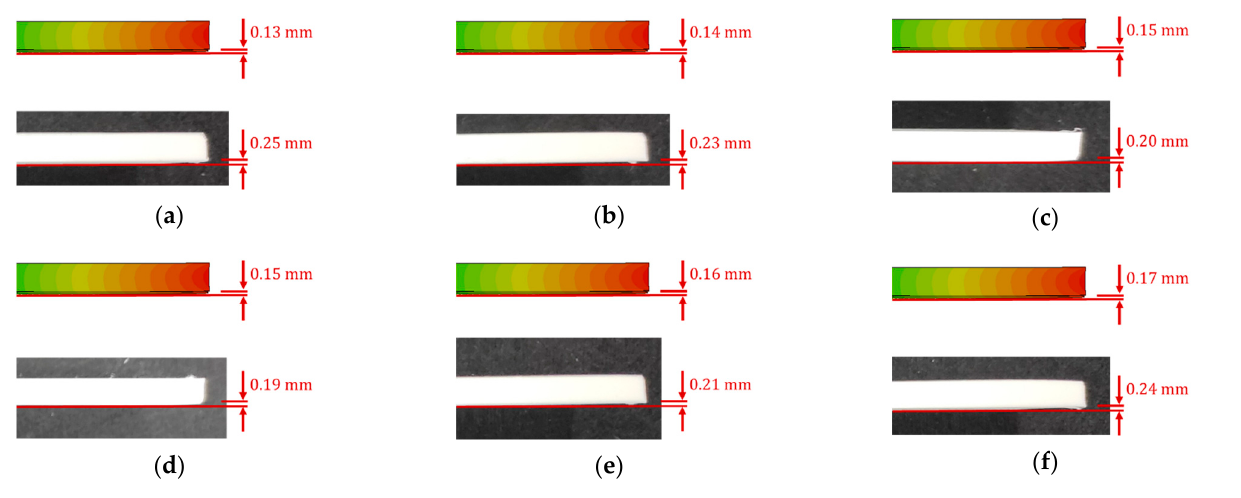
Figure 4. Numerically Predicted (Above) and Physically Measured (Below) Warpage for 3D Printed Samples at Different Temperatures ( a ) 210 °C ( b ) 220 °C ( c ) 230 °C ( d ) 240 °C ( e ) 250 °C ( f ) 260 °C. samples at different temperatures: ( a ) 210 ◦ C, ( b ) 220 ◦ C, ( c ) 230 ◦ C, ( d ) 240 ◦ C, ( e ) 250 ◦ C, ( f ) 260 ◦